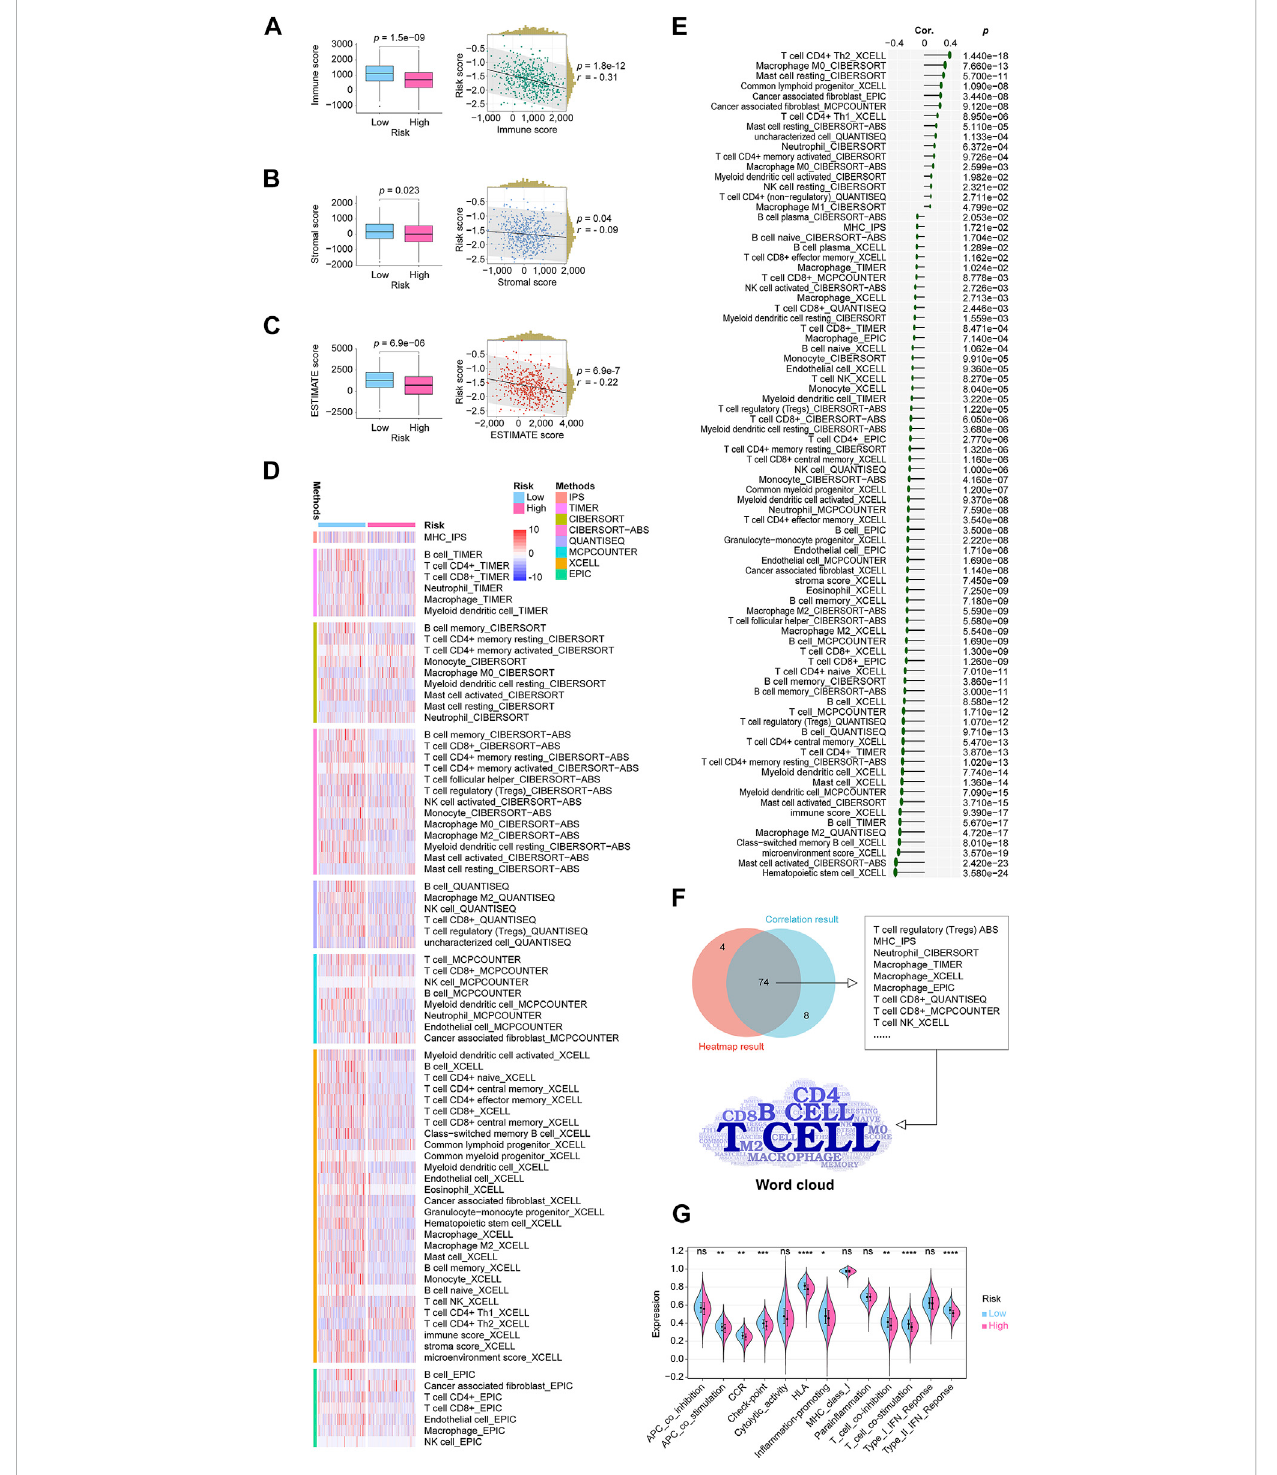
FIGURE 7 In-depth analytics on the relationship between the CRLncSig and the tumor microenvironment condition, immune cell in fi ltration, immune function. (A) A boxplot and a scatterplot display the relationship between the CRLncSig and immune score. (B) A boxplot and a scatterplot display the relationshipbetweentheCRLncSigandstromalscore. (C) AboxplotandascatterplotdisplaytherelationshipbetweentheCRLncSigandESTIMATEscore. (D) The heatmap demonstrated the in fi ltration distribution of eight types of immune cells generated from eight mainstream immunoinformatic algorithms in different CRLncSig scores. Only signi fi cantly distributed immune cells are exhibited. (E) The lollipop plot describes the in fi ltration correlationsofeighttypesofimmunecellswithCRLncSigscores.Onlysigni fi cantlyimmunecellsareshown. (F)